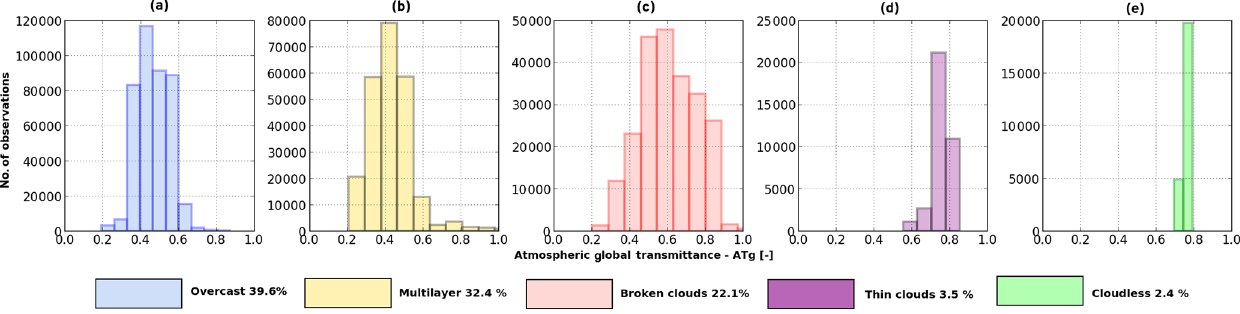
Figure 5. Histograms of atmospheric global transmittance (ATg) for (a) overcast, (b) multilayer, (c) broken cloud, (d) thin cloud, and (e) cloudless sky conditions. Table 2. Mean values of ambient temperature T a [K] and atmospheric global transmittance ATg [–] for case studies (C) and all periods (P). All results are based on the pyranometer